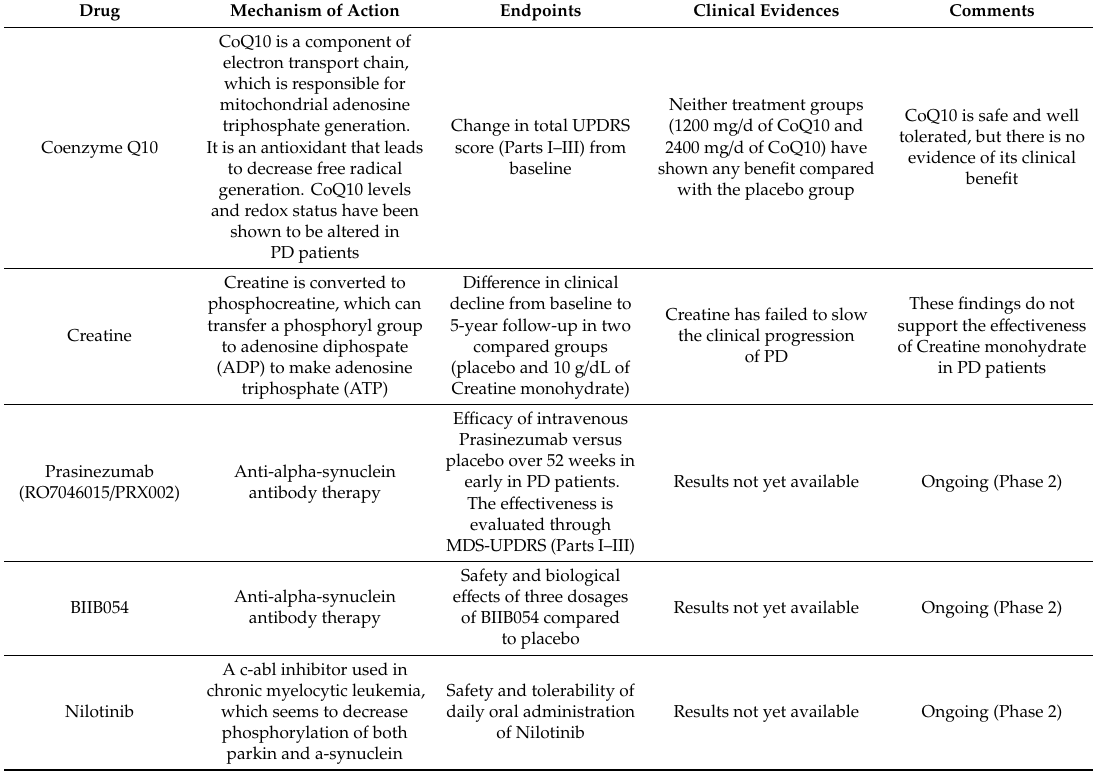
Table 2. Pharmacological trials in PD: critical